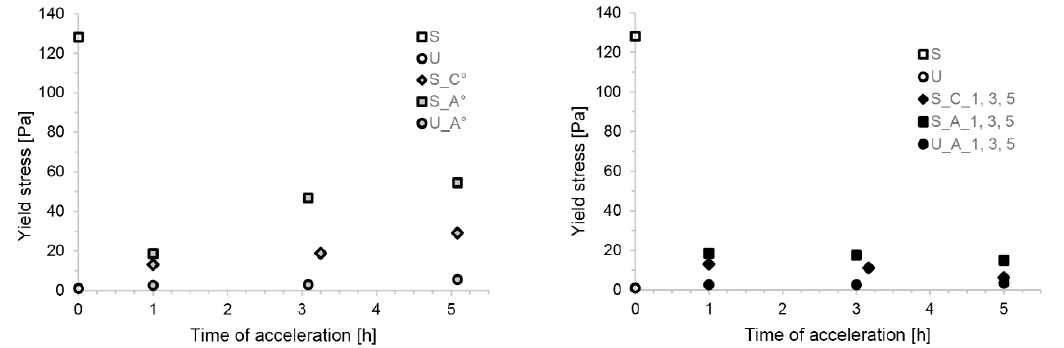
Figure 3. Mini-slump test results expressed as yield stress. On the left, the accelerator dosages were constant over time. On the right, time-dependent accelerator amounts were used.